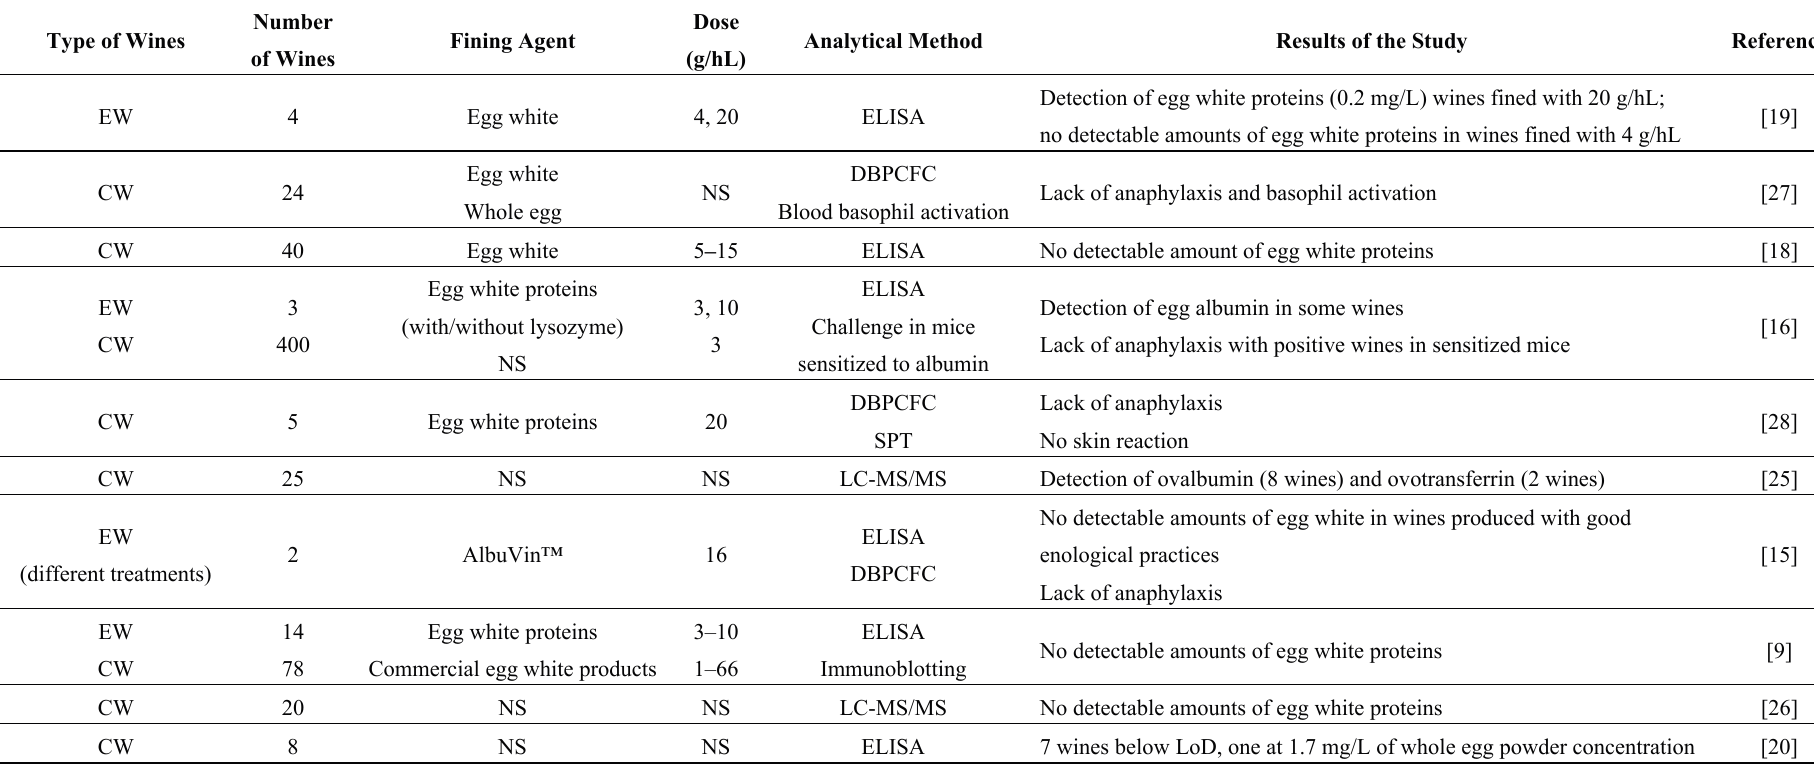
Table 2. Studies reporting data on allergenic residues in wines fined with egg